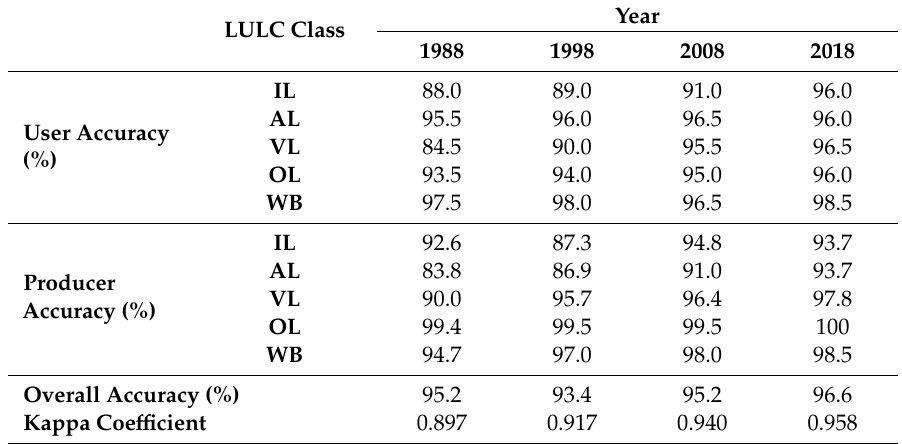
Table A2. The summary Land Use/Land Cover statistics of Kathmandu at 10-years interval from 1988 to 2018.